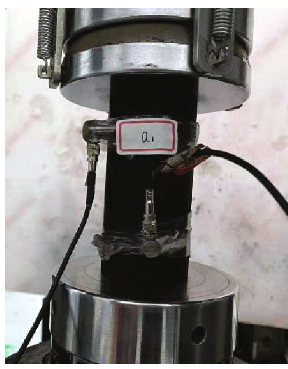
Figure 1: Ready condition of the coal sample.